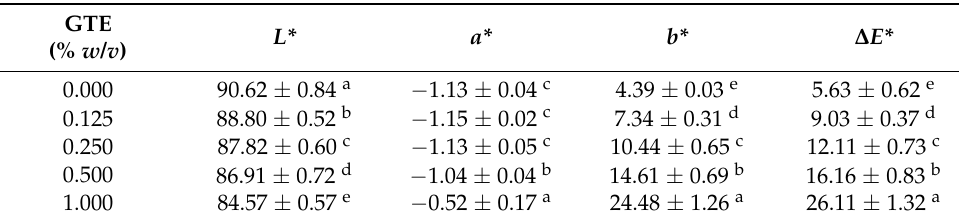
Table 2. Light transmission and transparency of rice-starch - pectin films incorporated with green tea extract at different concentrations . GTE ( % w/v )